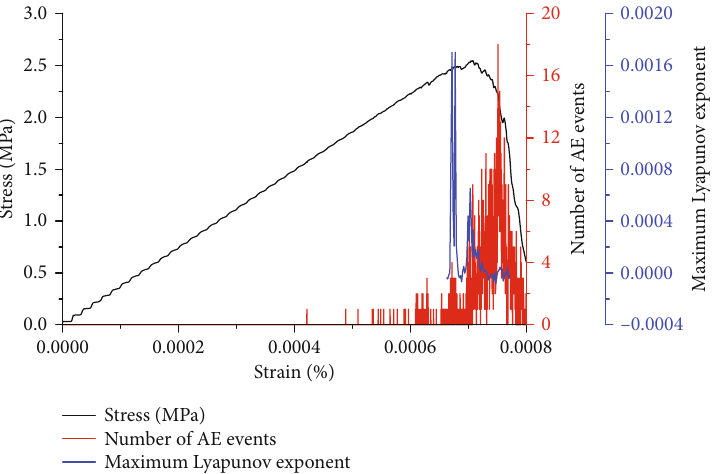
Figure 6: Stress-strain-number of AE events-maximum Lyapunov exponential variation diagram of specimen